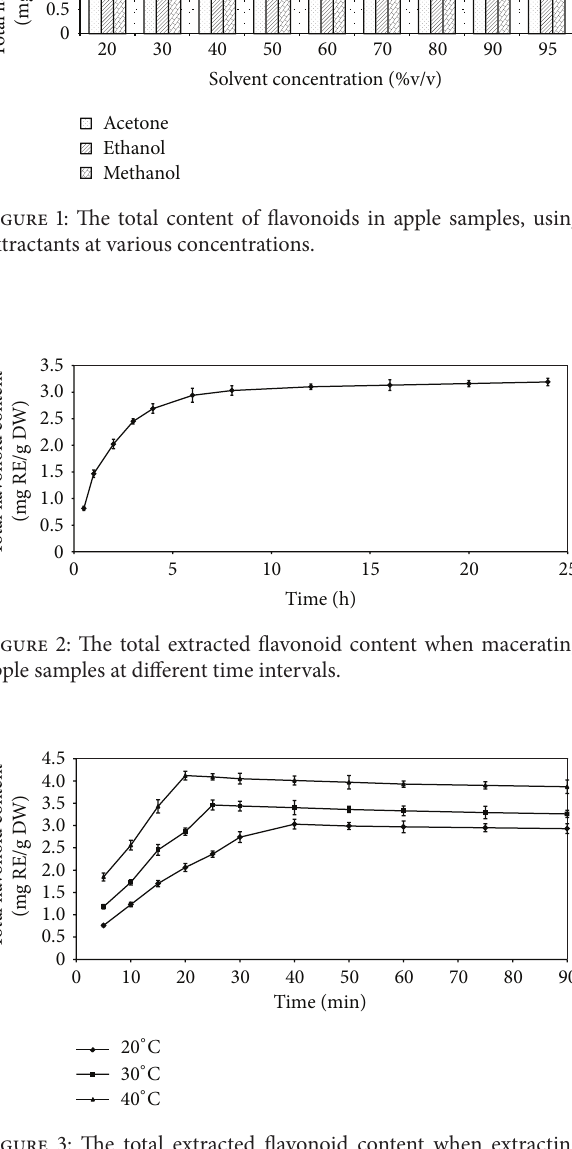
Figure 3: The total extracted flavonoid content when extracting apple samples in an ultrasound bath at different time intervals at the temperature of 20–40 ∘